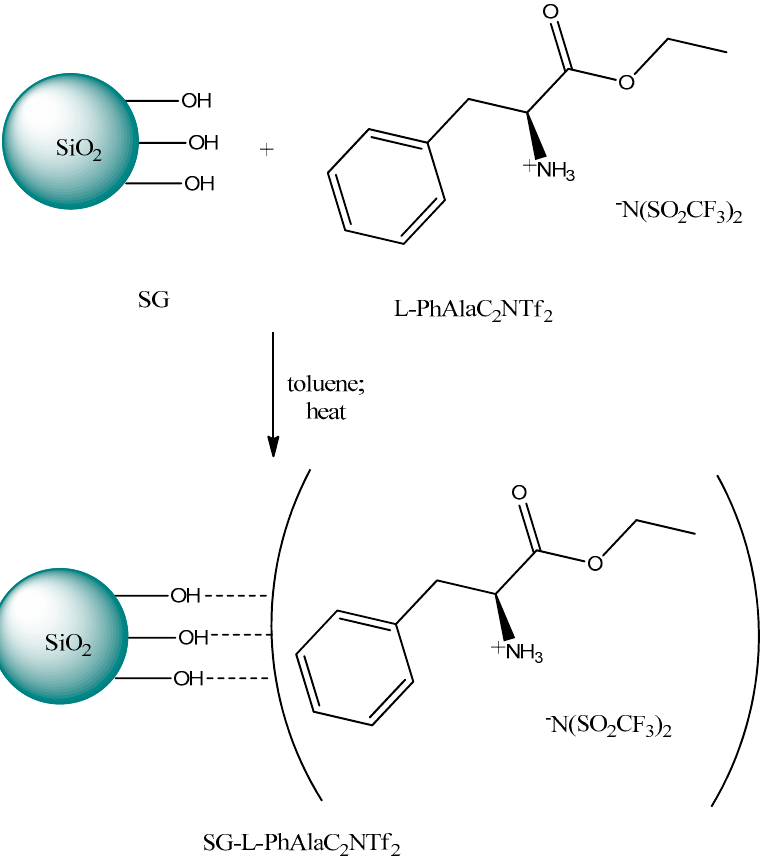
Figure 10. Synthetic route of the SG- L -PhAlaC 2 NTf 2 phase (adapted from Marwani, 2014) [172].